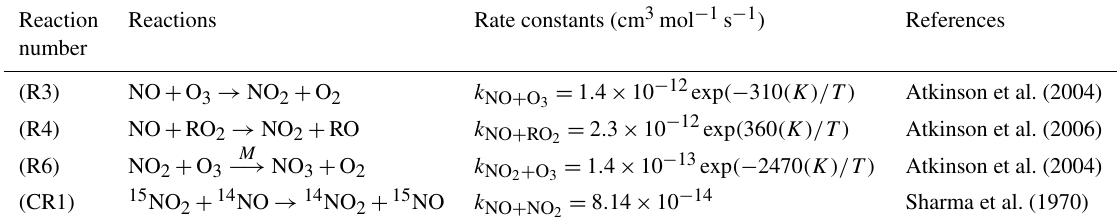
Table D1. Rate constants used for